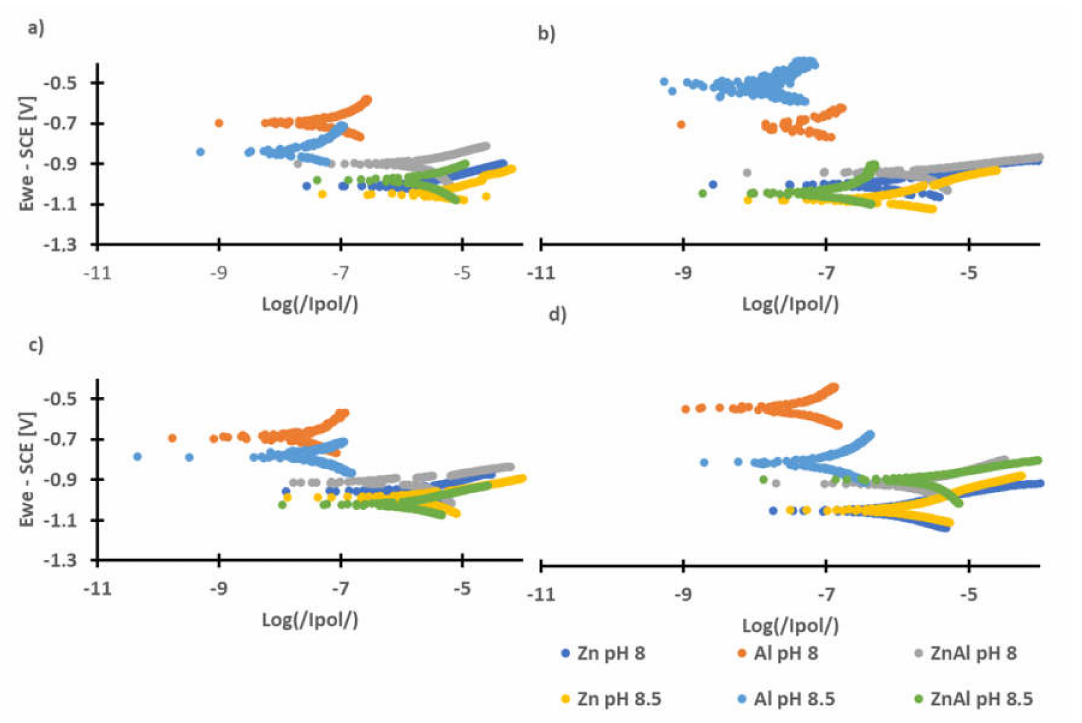
Figure 3. Polarization curves for arc sprayed coatings in: ( a ) alkalized water; ( b ) solution with 50 mg/L of chloride ions; ( c ) solution with 100 mg/L of sulfate ions, and ( d ) solution with 50 mg/L of chloride ions and 100 mg/L of sulfate